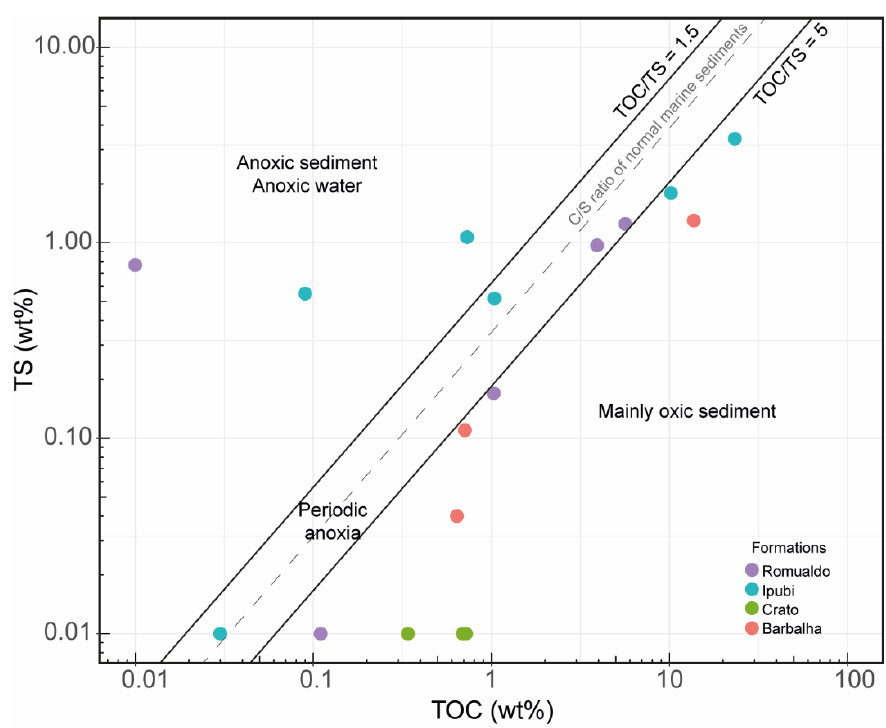
Figure 9. Total sulfur (TS) vs. total organic carbon (TOC) plot for interpreting the paleoredox conditions of the Santana Group. The dashed line represents the average C/S ratio for normal marine sediments (2.8) under oxygenated seawater conditions. Based on Berner [99,100] and Fleurance et al. [101].